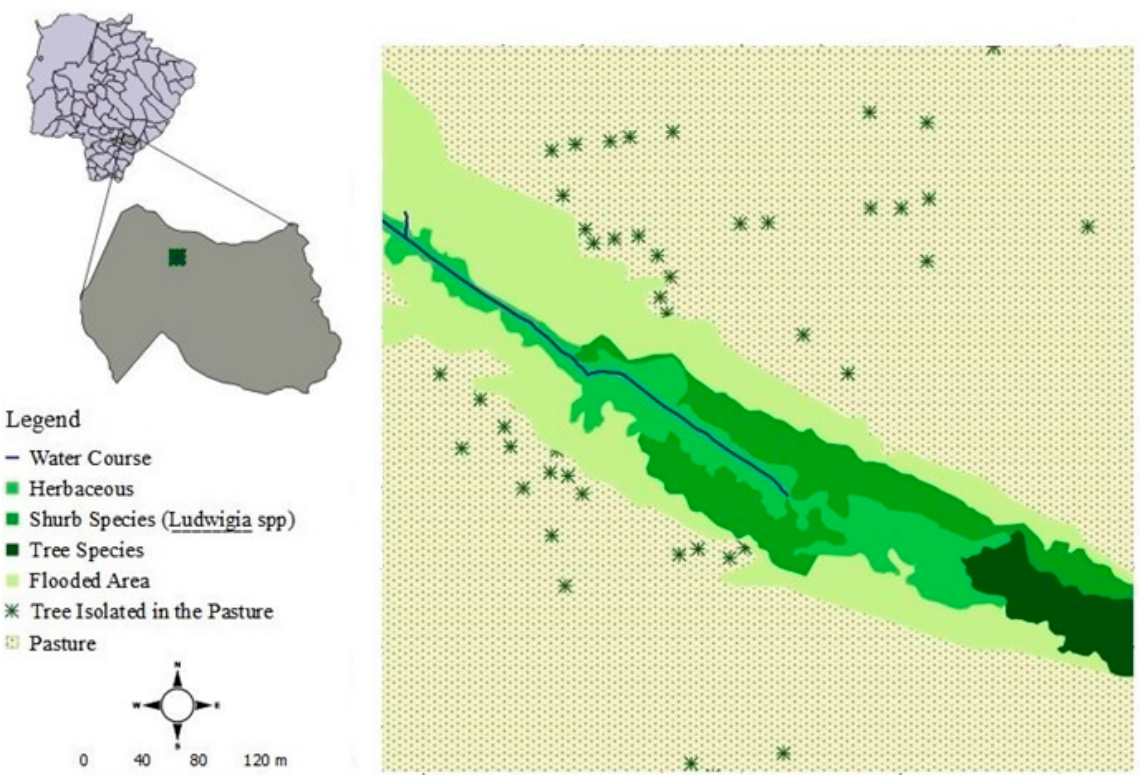
Figure 1. Map of the study site and distribution of Ludwigia spp.